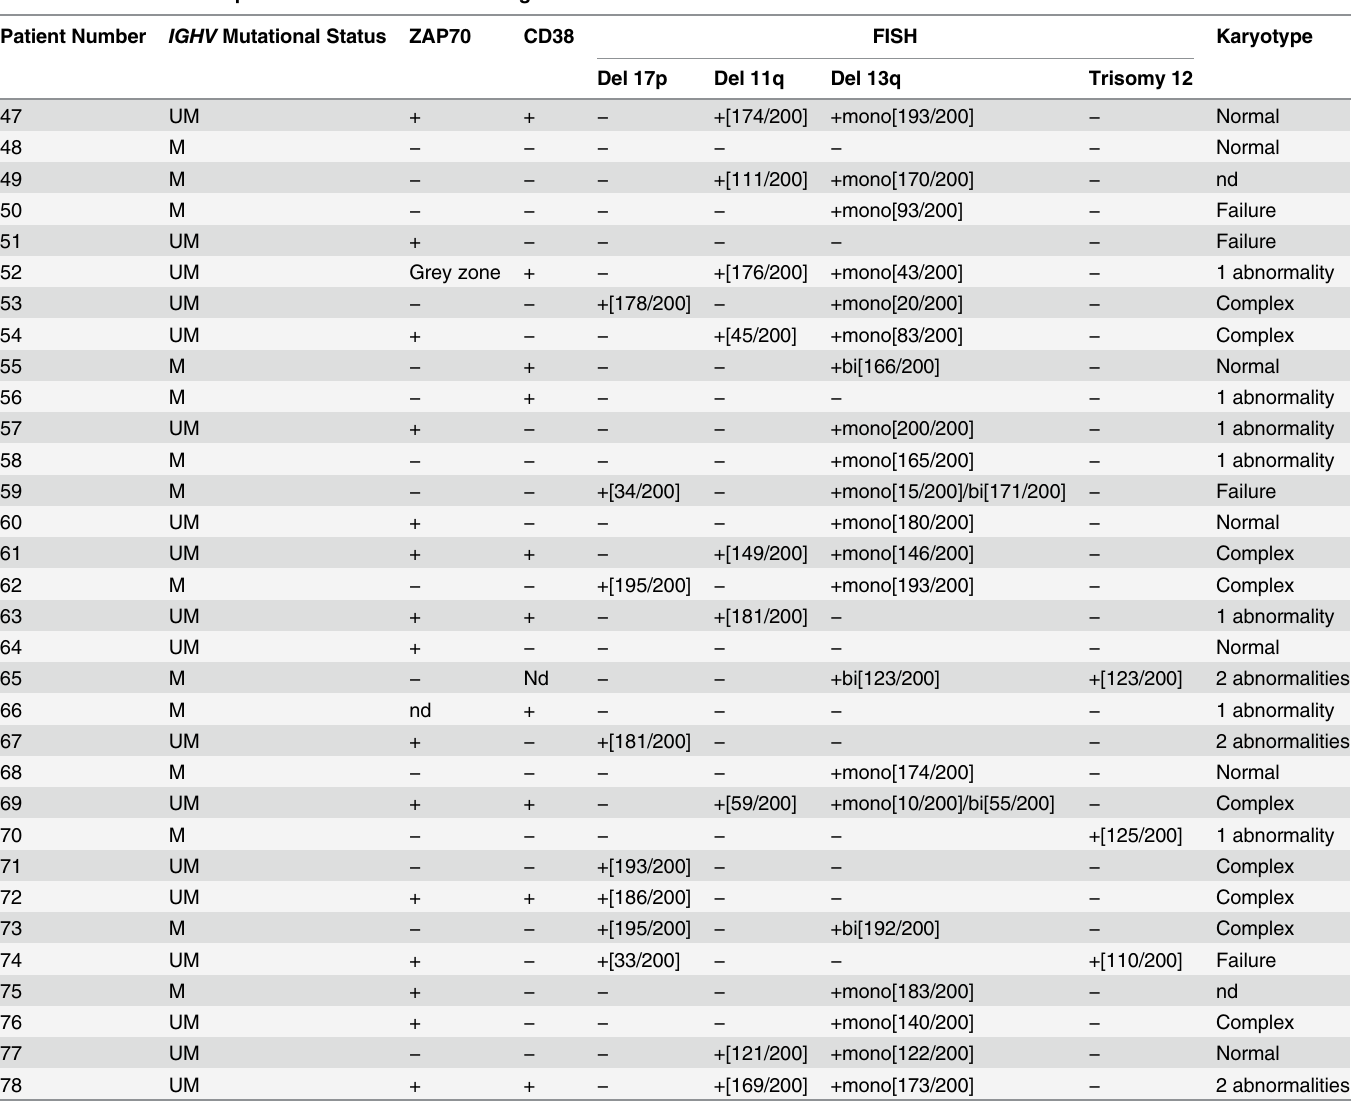
Table 2. Features of CLL patients with clinical Binet Stage